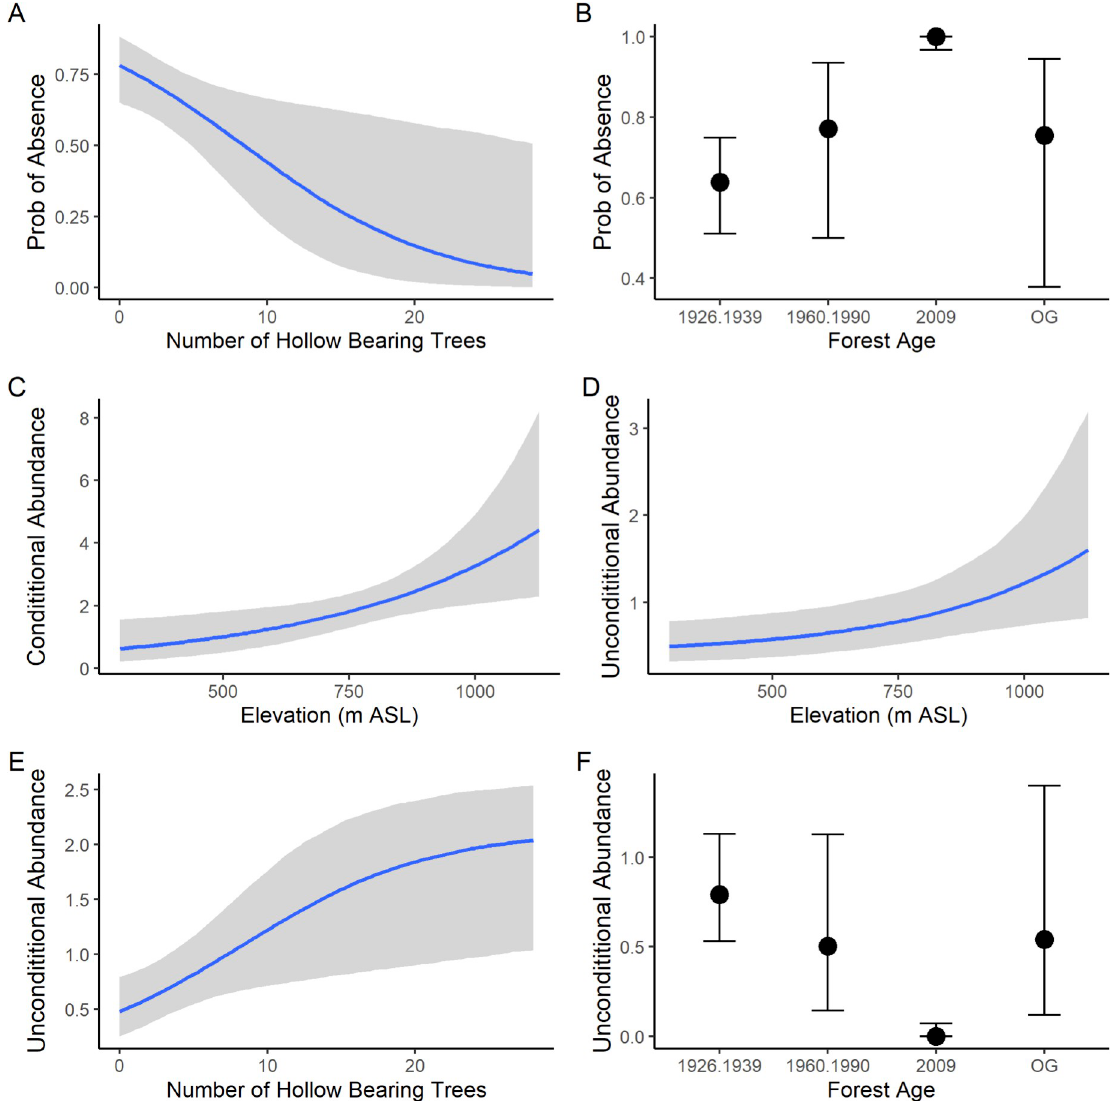
Fig 2. The results of statistical modelling for the Southern Greater Glider. The abundance of hollow-bearing trees (A) and forest age (B) in the hurdle portion of the model (i.e. the probability of the species being detected at a site). “Prob” = probability. The effect of Elevation at a site in the conditional abundance portion of the model (given the species is present) (C). Combined model (i.e. unconditional abundance) effects that include elevation (D), the abundance of hollow-bearing trees (E), and forest age (F) (OG = stands dating from before